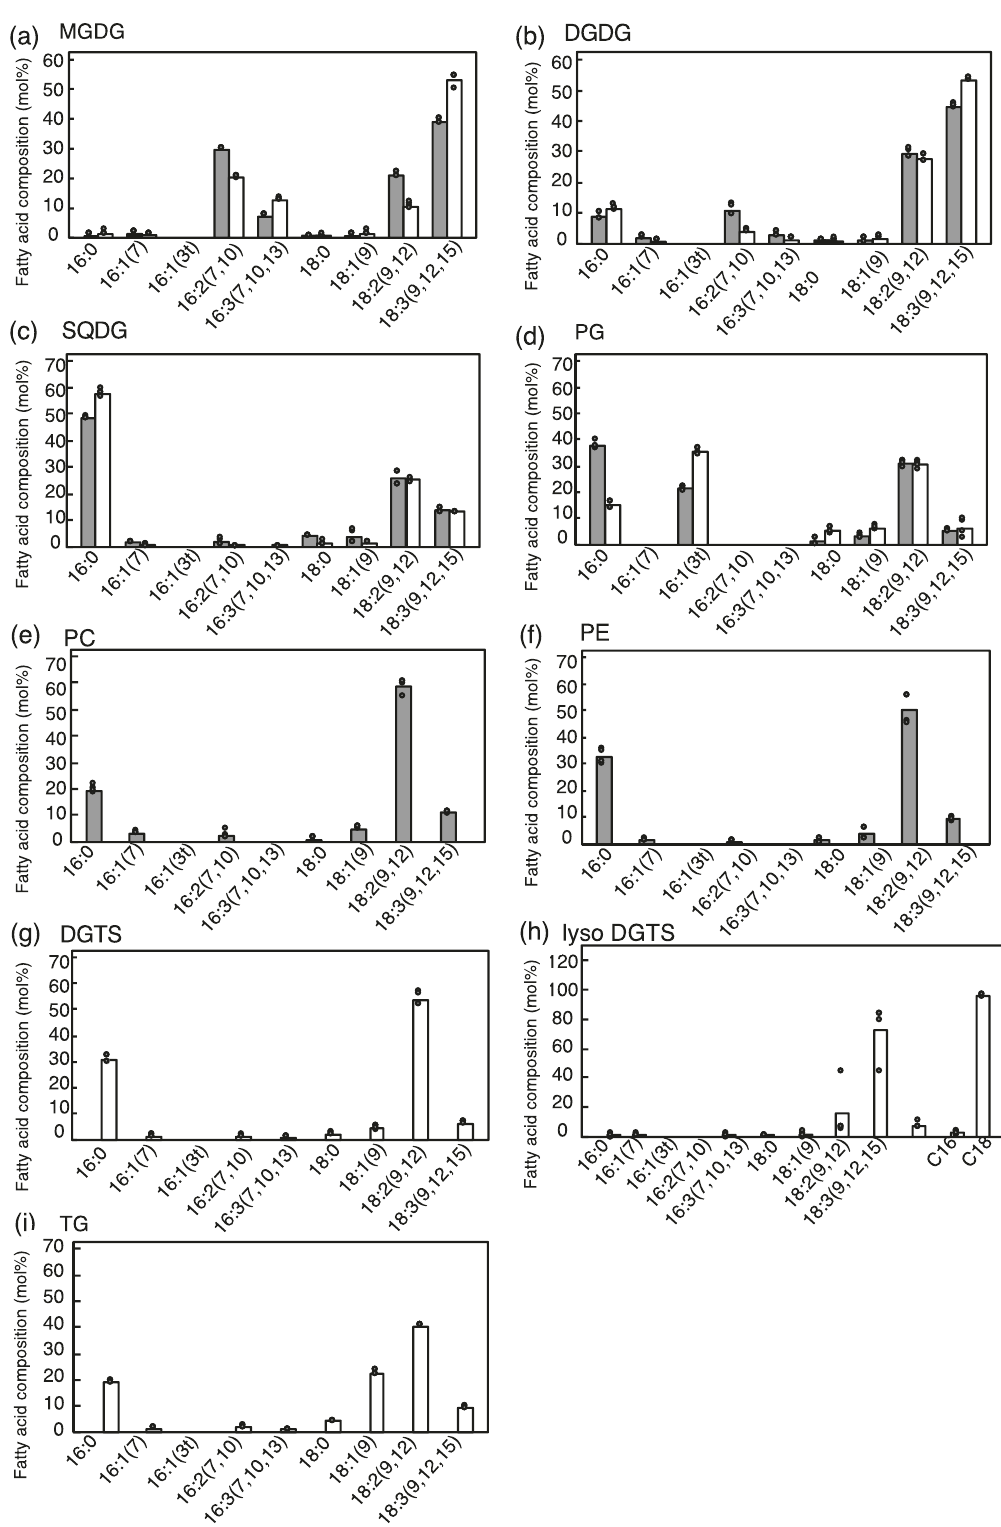
Fig. 5 Fatty acid composition of individual polar lipids. The fatty acid compositions of MGDG ( a ), DGDG ( b ), SQDG ( c ), and PG ( d ) are shown for 48-h grown + P (gray bars) and − P cells (white bars), whereas those of PC ( e ) and PE ( f ), and DGTS ( g ) are for + P and − P cells, respectively. The fatty acid composition of sn -2 monoacyl lysoDGTS is shown in ( h ). Fatty acid composition of TG in − P cells is shown in ( i ). The values shown are averages for two technical replicates for each of two biological replicates. Some dots are overlapped (refer to source data in Supplementary Data